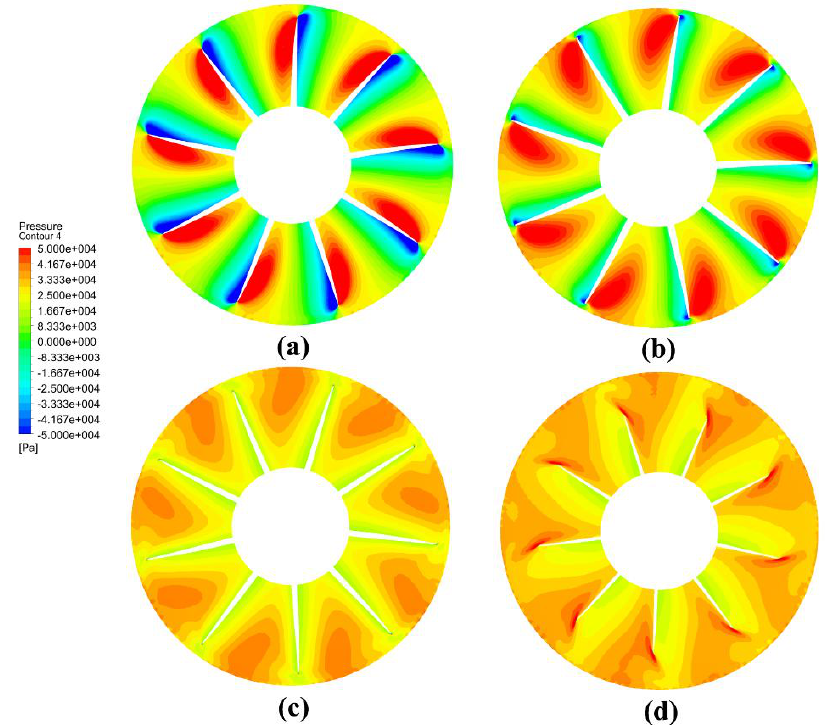
Figure 21. Axial section pressure distribution of rotor designed by lifting-line method: ( a ) 20% rotor channel, ( b ) 40% rotor channel, ( c ) 70% rotor channel, and ( d ) 90% rotor channel.